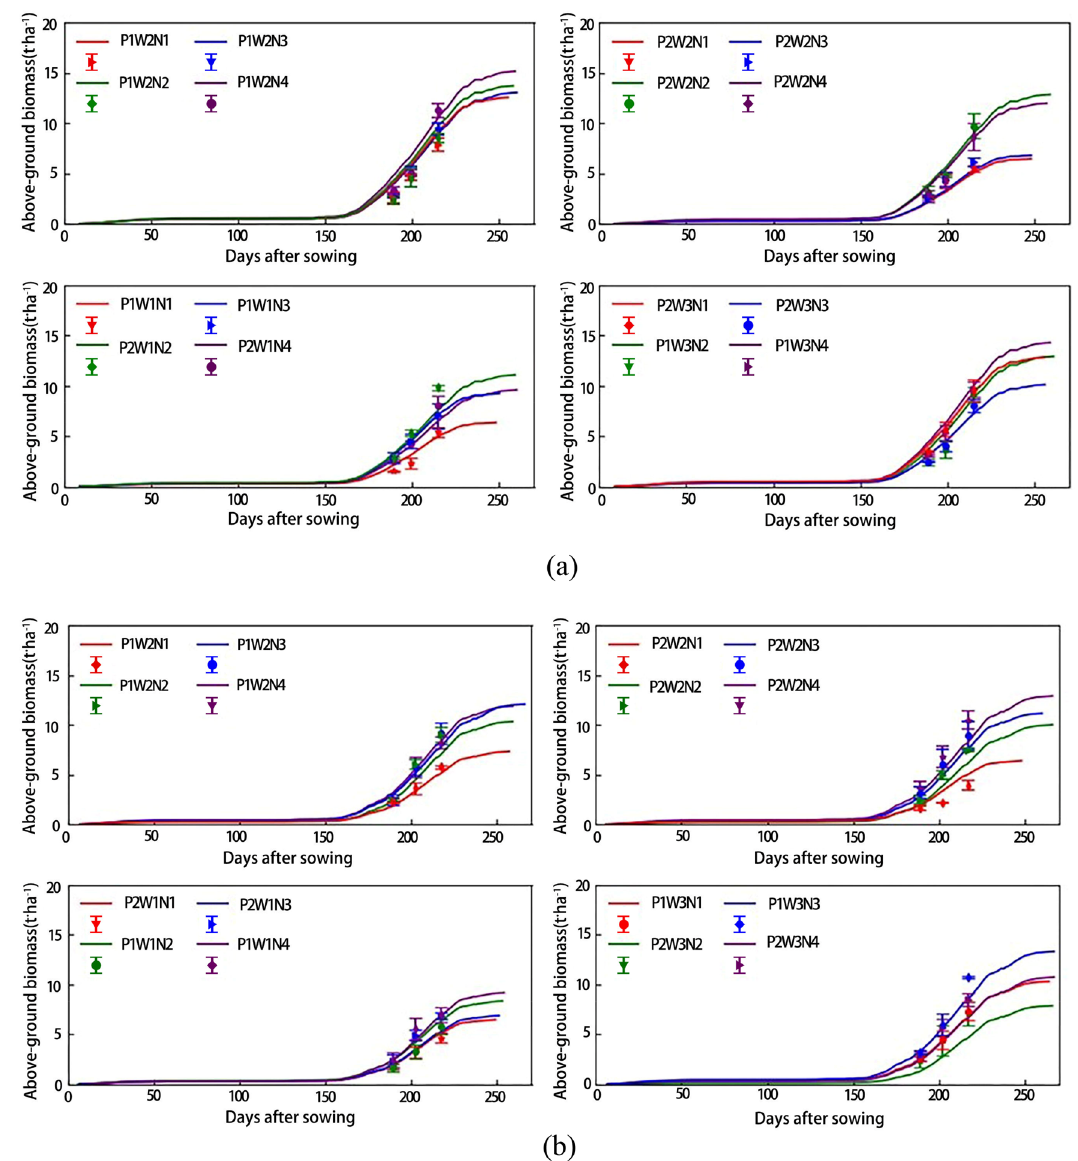
Figure 5. The relationships between the estimated and measured wheat DAM values for different wheat varieties and different irrigation and fertilizer settings in 2014 ( a ) and 2015 ( b